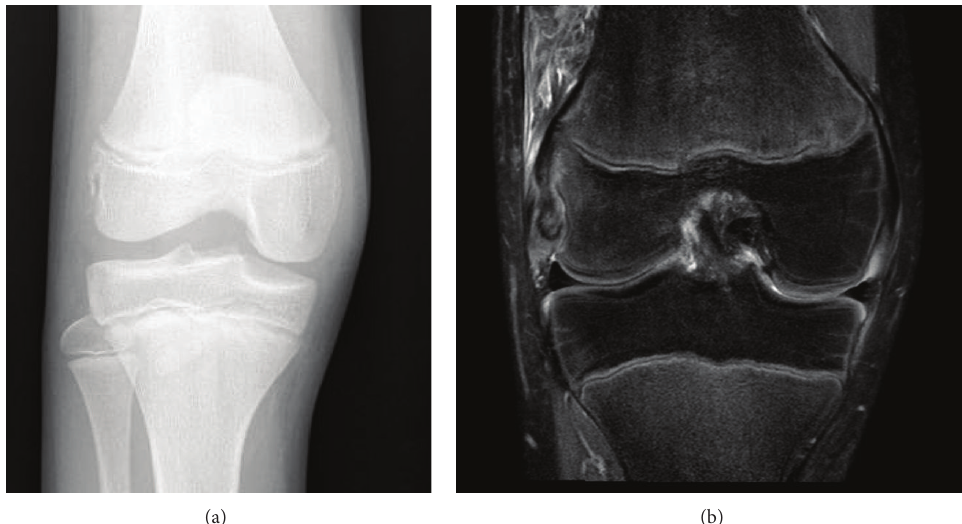
Figure 1: (a) Case 1 injury AP knee showing lateral distal femoral avulsion fracture. (b) Case 1 T2 MRI showing popliteus tendon avulsion.